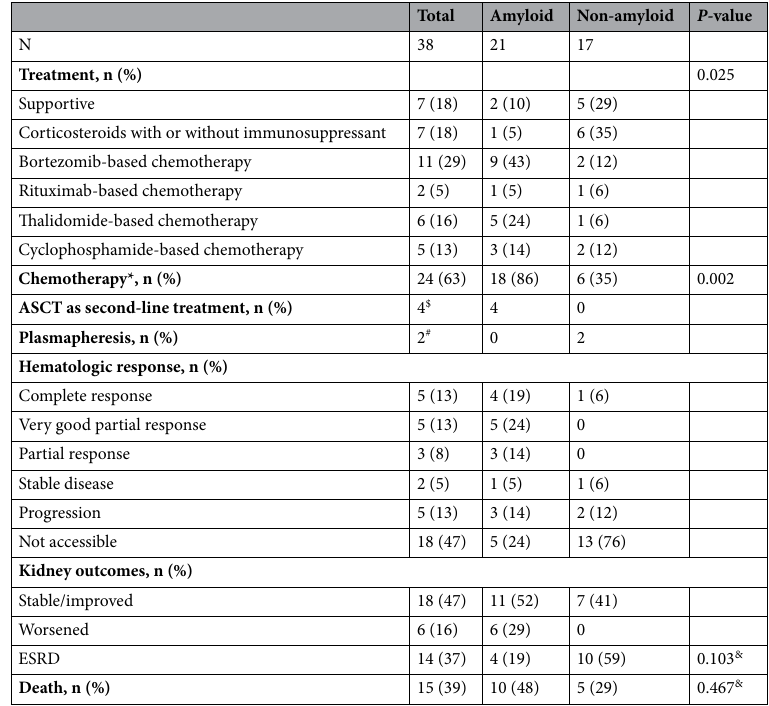
Table 2. Treatment and outcomes of patients with MGRS with IgM Monoclonal Gammopathy. *Chemotherapy included bortezomib-based chemotherapy, rituximab-based chemotherapy, thalidomide- based chemotherapy, and cyclophosphamide-based chemotherapy. $ ASCT were used in four patients, including two patients followed cyclophosphamide-based chemotherapy, and two patients followed bortezomib-based chemotherapy. # These two patients were also treated with corticosteroids. & Log-rank test was used to compare survival between amyloid and non-amyloid